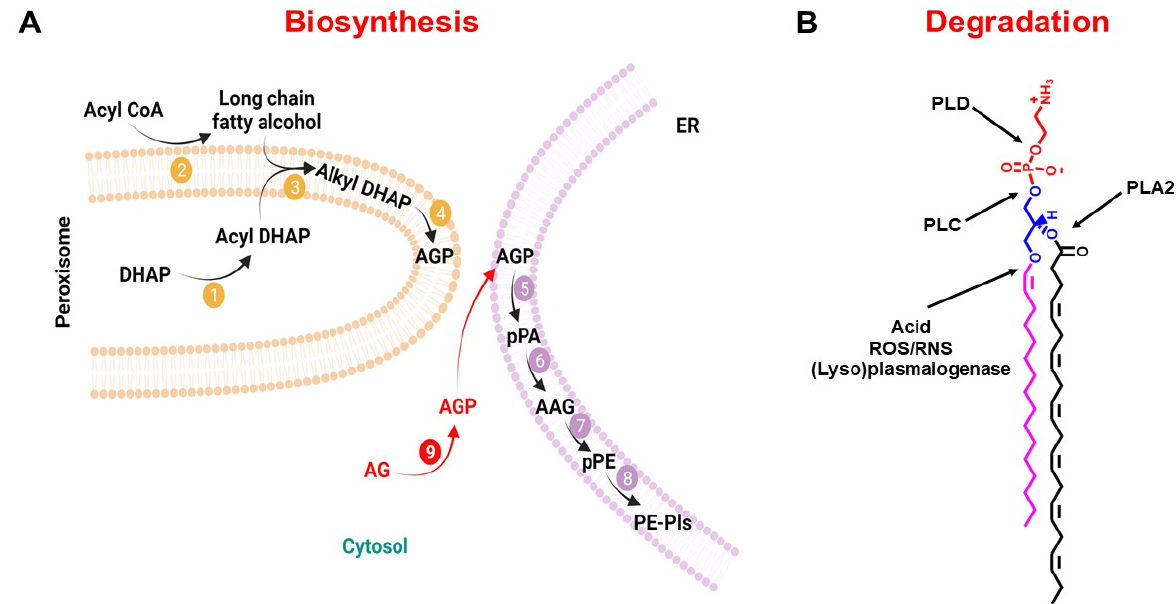
Figure 2. Metabolism of plasmalogen. ( A ) Biosynthesis pathway. Initial biochemical reactions start in the peroxisome with the production of 1-acyl-dihydroxyacetone phosphate (1-acyl DHAP) and delivery of 1-alkyl-2-lyso- sn -glycero-3-phosphate (AGP) to the ER. In the ER, AGP undergoes four consecutive biochemical reactions to yield PE-Pls. PC-Pls is produced via headgroup transfer and/or remodeling of PE-Pls. Biochemical reactions are catalyzed by 1—GNPAT, 2—Far1, 3—AGPS, 4—AADHAP-R, 5—AAG3P-AT, 6—PAP-1, 7—EPT, and 8—PEDS1. Exogeneous AG crosses the plasma membrane and is phosphorylated in the cytosol (biochemical reaction 9) by an alkyl glycerol kinase before entering the biosynthesis pathway in the ER. ( B ) Degradation pathway. Plasmalogen degradation can occur by the activity of different phospholipases (PLC, PLD, and PLA2) as well as by chemical oxidation/hydrolysis of the vinyl-ether bond. The reader is referred to abbreviations for the names of the lipid intermediates and enzymes found at the end of this article. Schematic representations were generated using Biorender (©BioRender-biorender.com, San Francisco, CA, USA).